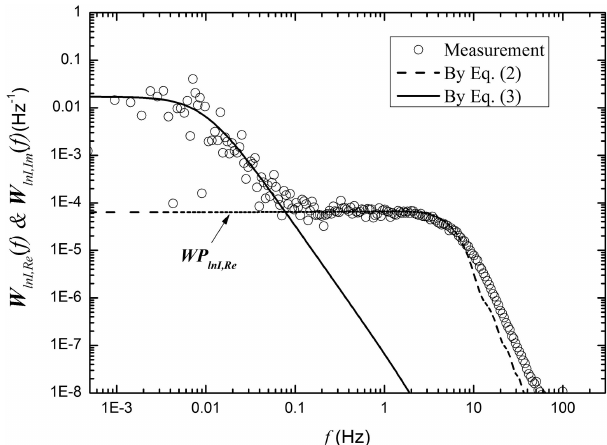
Figure 4. LAS observation at 08:30LT on 15 January 2014 used to derive spectral parameters. A theoretical calculation is shown for comparison. The temporal spectral densities ( W ln I, Re (f ) and W ln I, Im (f )) of the logarithmic light intensity fluctuations (circles) and the theoretical curves associated with the real and imaginary parts of the ARISP (solid line and dashed line, respectively) are plotted. WP ln I, Re refers to the spectral density of the plateau region described by Eq. (4) in the text.